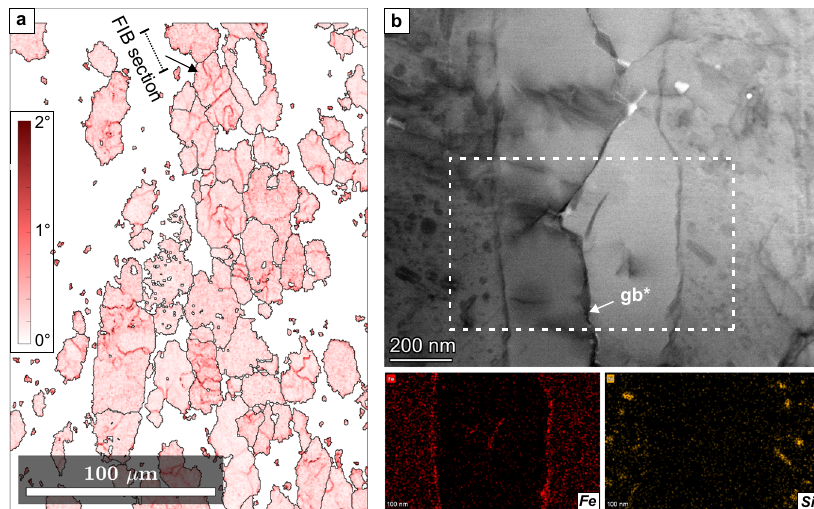
Fig. 6 Low-angle boundaries in magnesite within foliated listvenite. a Electron backscatter diffraction (EBSD) kernel average misorientation map of magnesite (3° threshold); the magnesite grain selected for transmission electron microscopy (TEM) analysis and the orientation of the focused ion beam (FIB) section are indicated. b Scanning TEM bright- fi eld image of a low-angle boundary (gb*) in the selected magnesite grain, and Fe and Si compositional maps of the framed area. (Sample